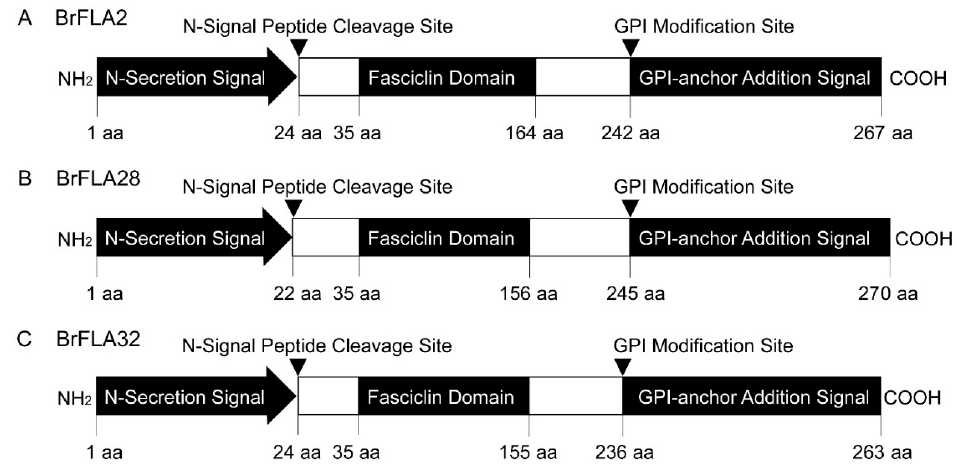
Figure 4. Structure schematic representation of three BrFLA proteins deduced from DNA sequences. ( A ) BrFLA2. ( B ) BrFLA28. ( C ) BrFLA32.